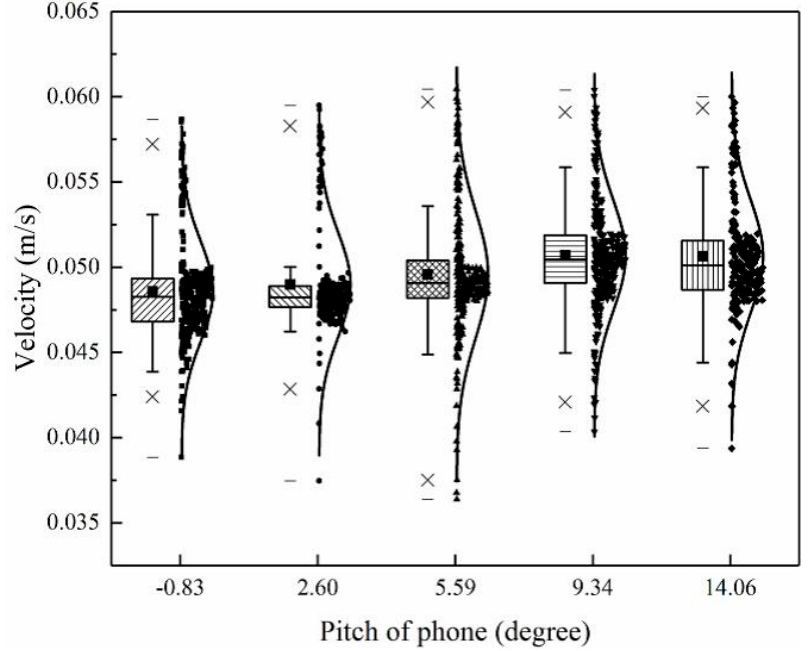
Figure 4. Measurement results at the different pitch of phone.